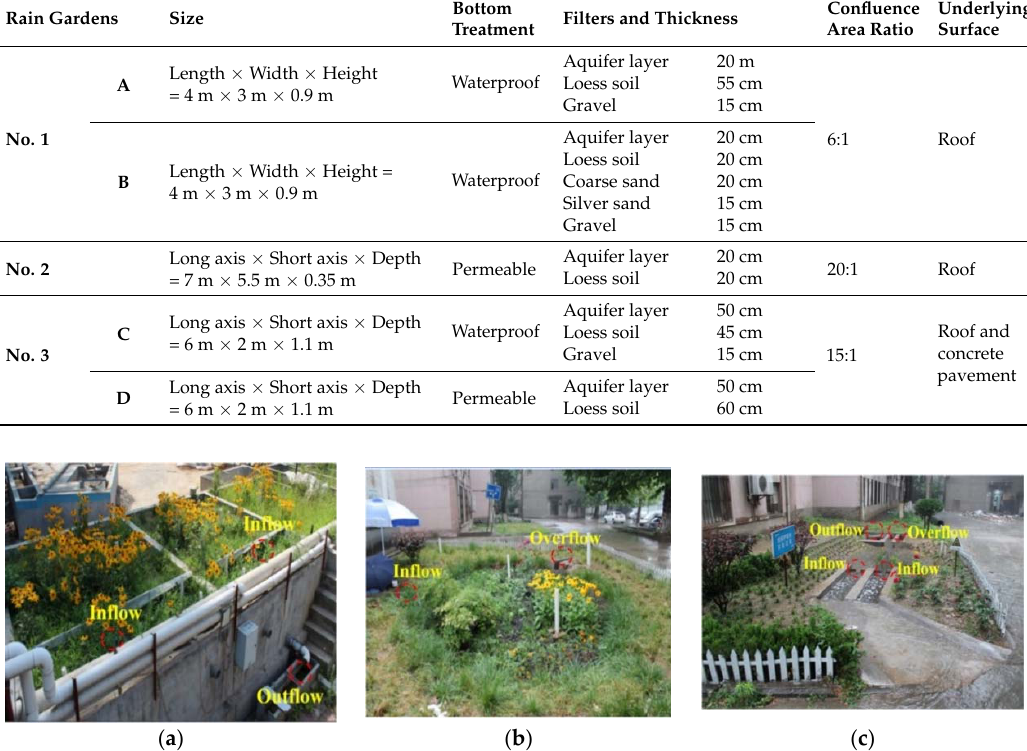
Figure 2. Scene drawingof three rain gardens at Xi’an University of Technology. Note: Inflow refers to the site of runoff from road or roof flows into rain gardens; Outflow refers to the site of runoff discharged from the rain gardens; Overflow refers to the site of runoff failed to permeate overflow into municipal pipe. ( a ) Rain garden No. 1; ( b ) Rain garden No. 2; ( c ) Rain garden No. 3.